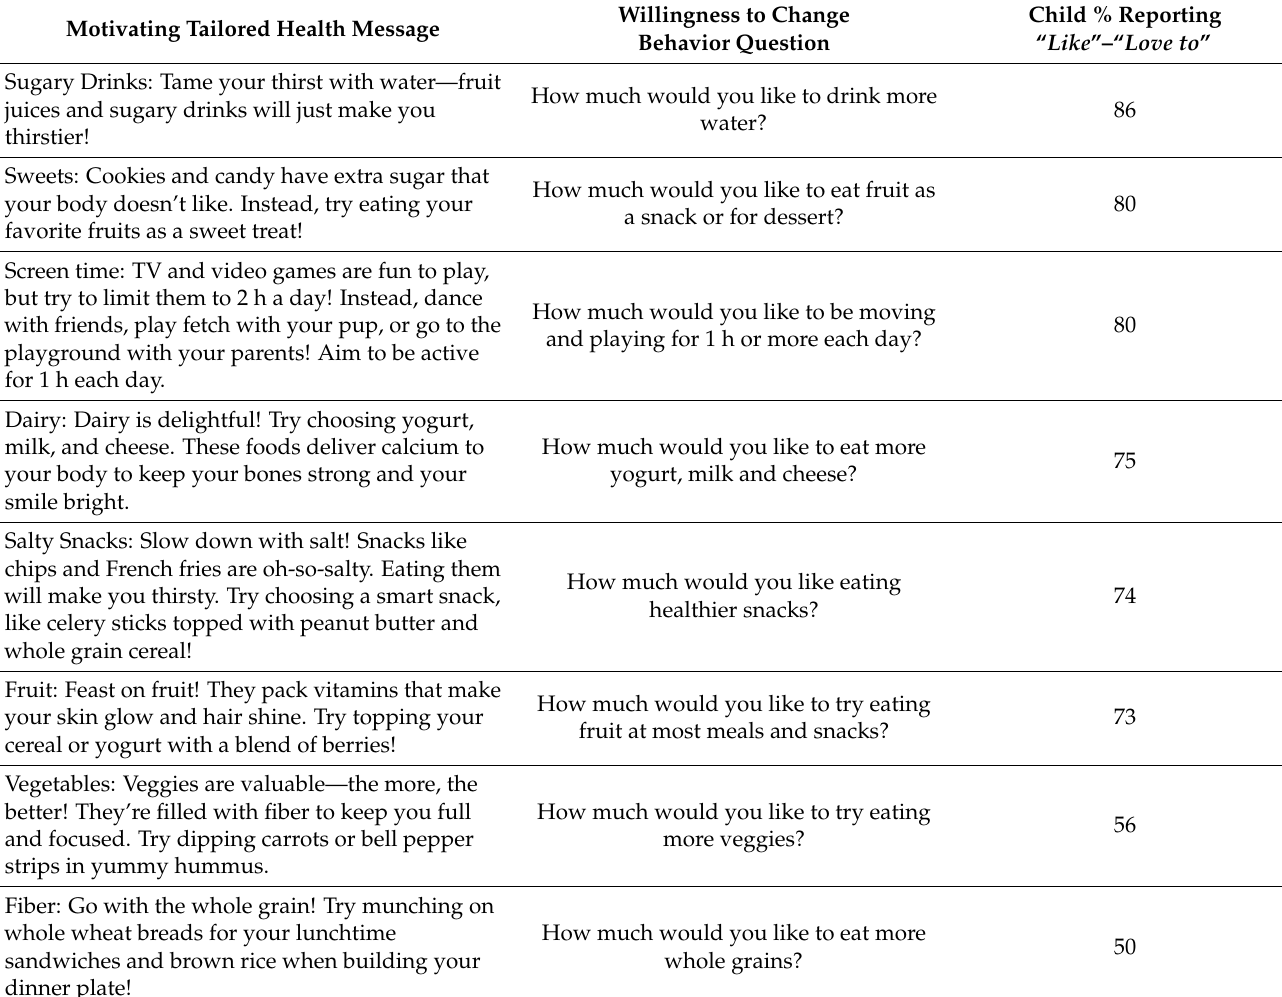
Table 2. Health messages by topic and child’s willingness to try new health